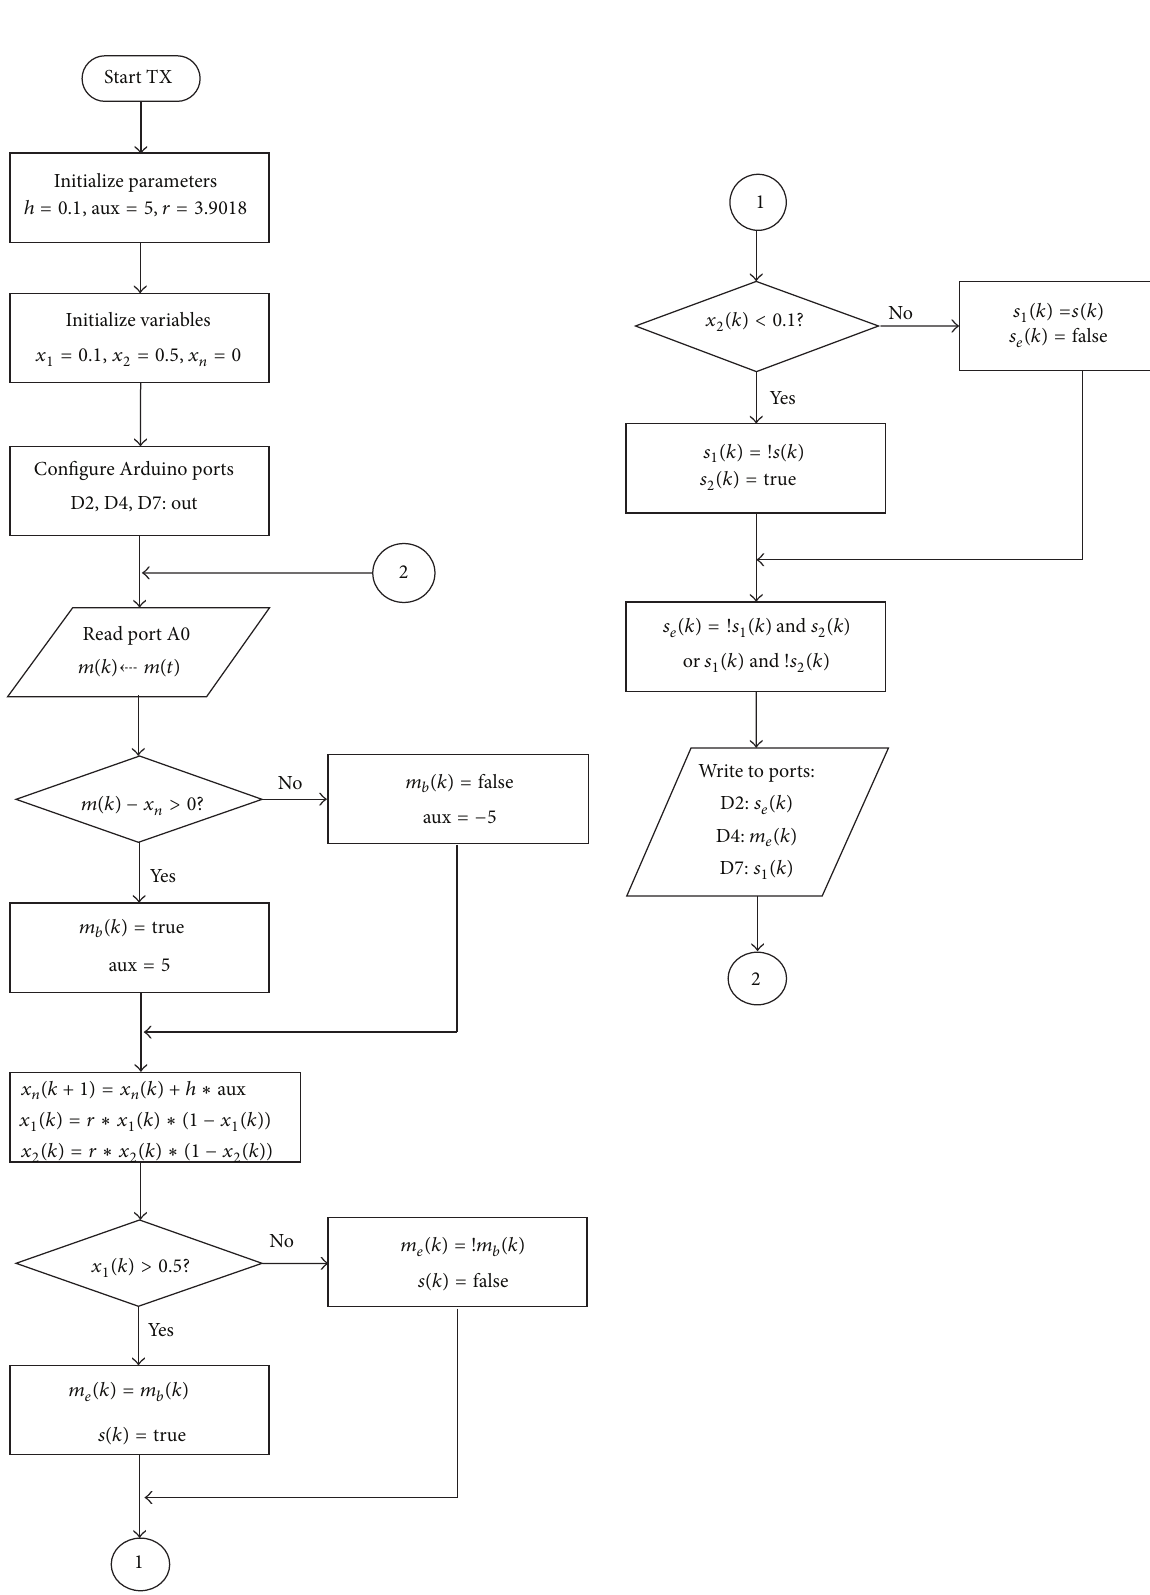
Figure 4: Flow diagram of the transmitter Arduino